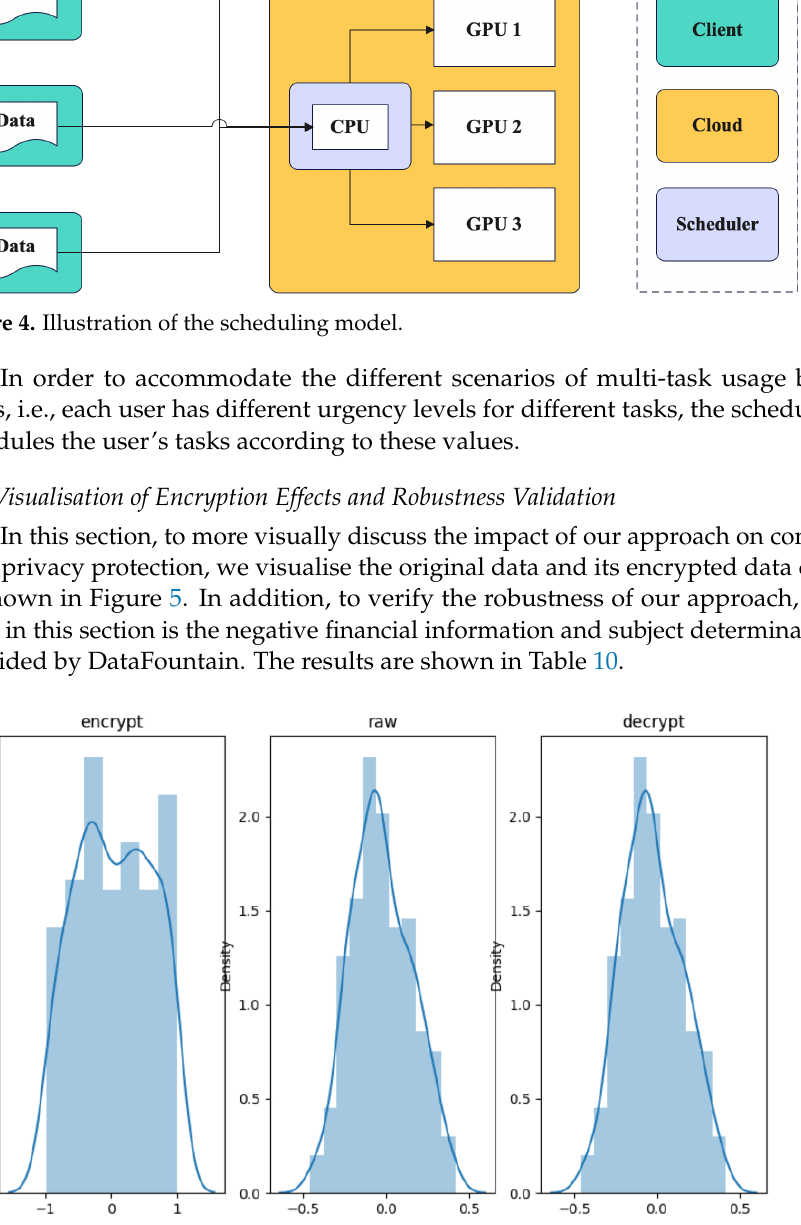
Figure 5. Visualisation of data distribution based on the encryption and decryption of raw data by the method in this paper. Table 10. Accuracy quantisation on our method with named entity recognition